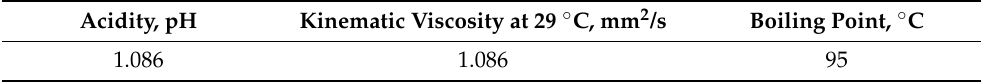
Table 4. Selected properties of the coolant oil